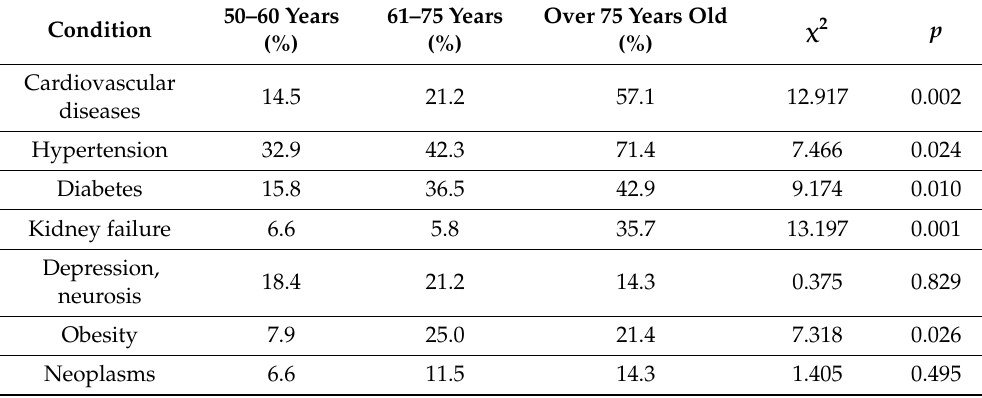
Table 2. Characteristics of the study group showing the relationship of the observed diseases with the age of the respondents.